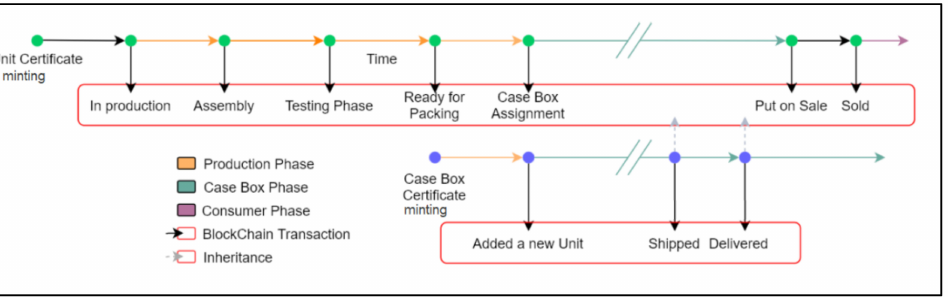
Figure 10. Process flow of pharmaceutical factory packaging using the blockchain